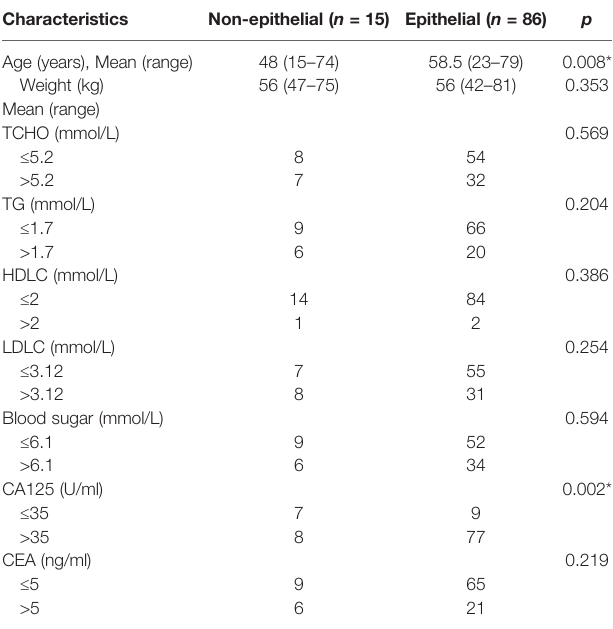
TABLE 2 | Univariate analysis of preoperative clinical factors associated with histological subtypes. Characteristics